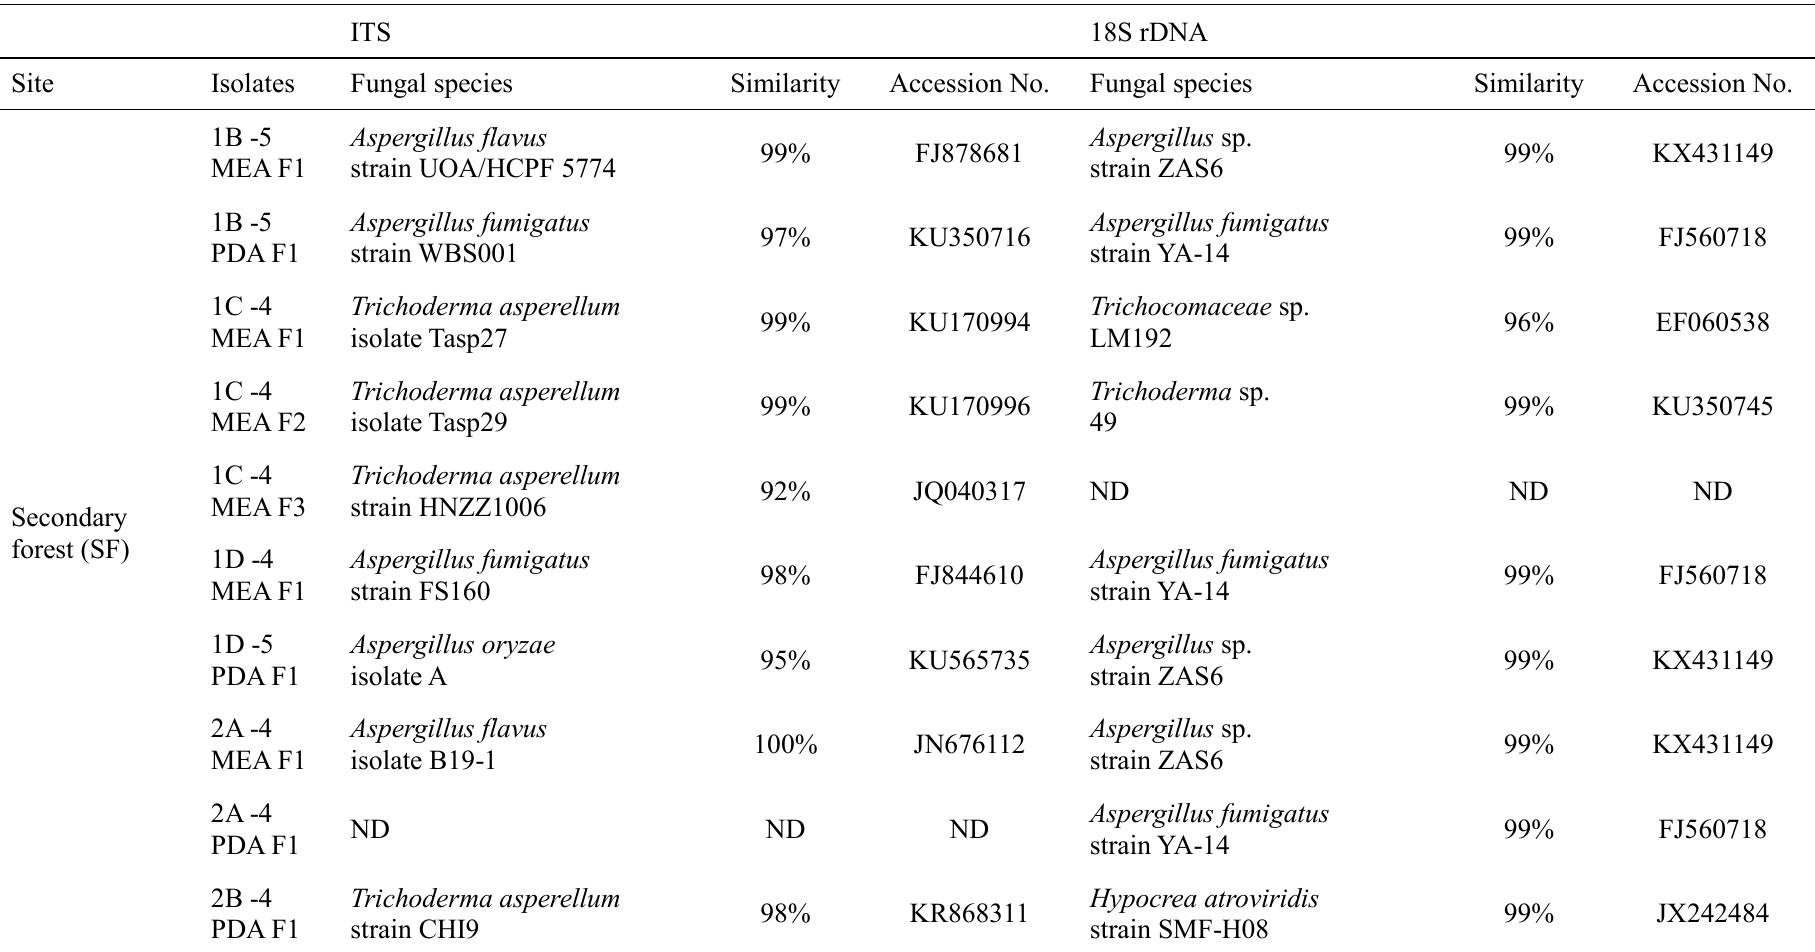
Table A2. List of fungal isolates identified from the three ecosystems and amplified using ITS and 18S rDNA primers, in each case showing the species/strain and NCBI accession number of the closest match in the GenBank database. MEA = malt extract agar; PDA = potato dextrose agar; ND = not detected ( i.e . no GenBank record corresponding to the sequence); YAP = years after